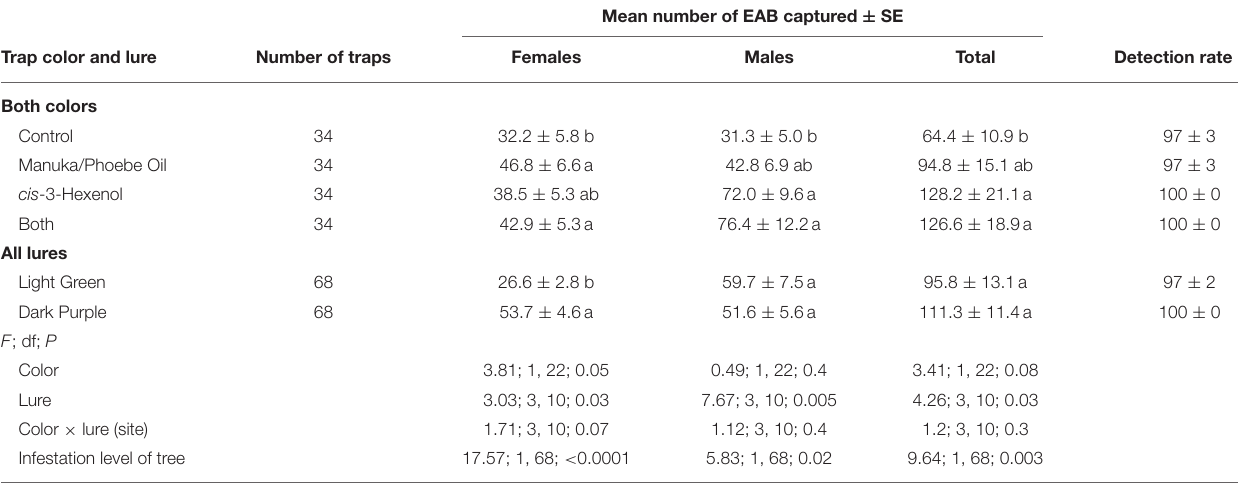
TABLE 2 | Mean number ( ± SE) of A. planipennis captured and detection rate (percentage of traps that captured at least one beetle) in Experiment 1 that compared green or purple sticky prism traps baited with a blend of Manuka and Phoebe oil (50 mg/day), cis -3-hexenol (7.4 mg/day), or both.